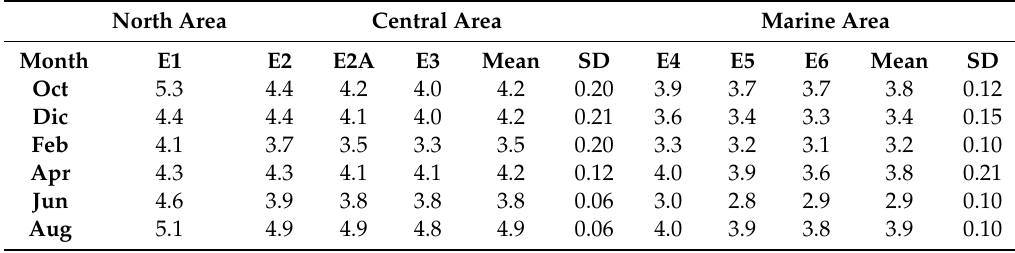
Table A2. The Trophic index (TRIX) values for the seven stations of the Juluapan Lagoon, along with the mean and standard deviation (SD) by area during the sampling